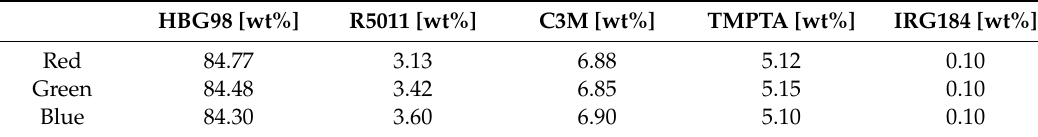
The polymer-stabilized blue phase liquid crystal precursors with di ff erent chiral dopant concentrations. HBG98 [wt%] R5011 [wt%] C3M [wt%] TMPTA